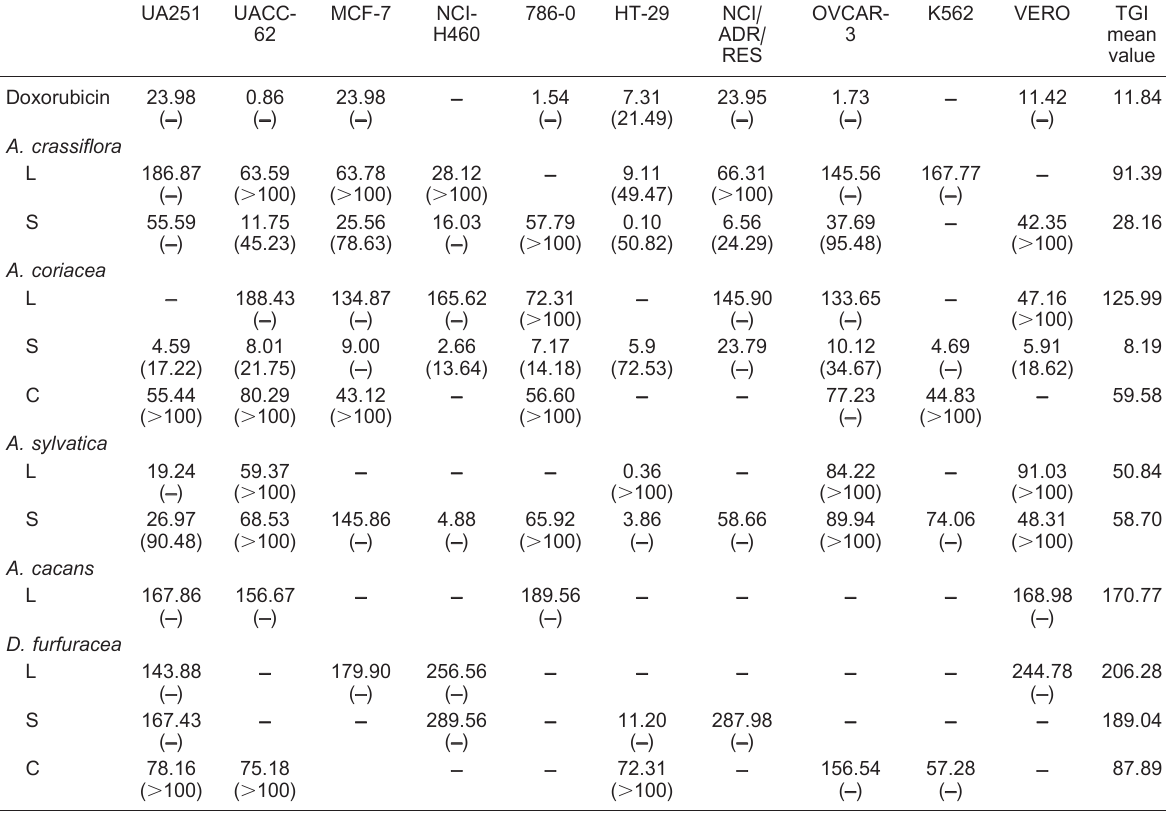
Table 3. Cytostatic (TGI, m g/mL) and cytocidal effects (LC 50 , m g/mL; data in parentheses) for methanolic extracts from the